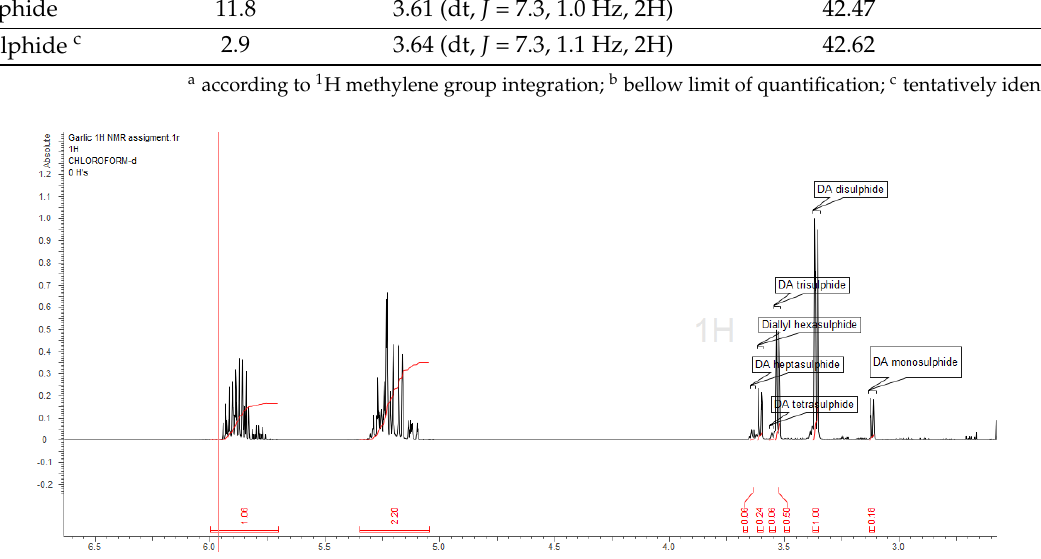
Figure 2. Fragment of garlic essential oil 1 H NMR spectrum. 2.2.3. Ceylon Cinnamon Essential Oil In the case of the second essential oil, cinnamon, its main component was trans- cin- namaldehyde (54.7%). Other compounds with the highest contribution were linalool (5.5%), cinnamyl acetate (4.3%) and trans -caryophyllene (4.1%). Table 13. GC-MS profile of Ceylon cinnamon essential oil . No.